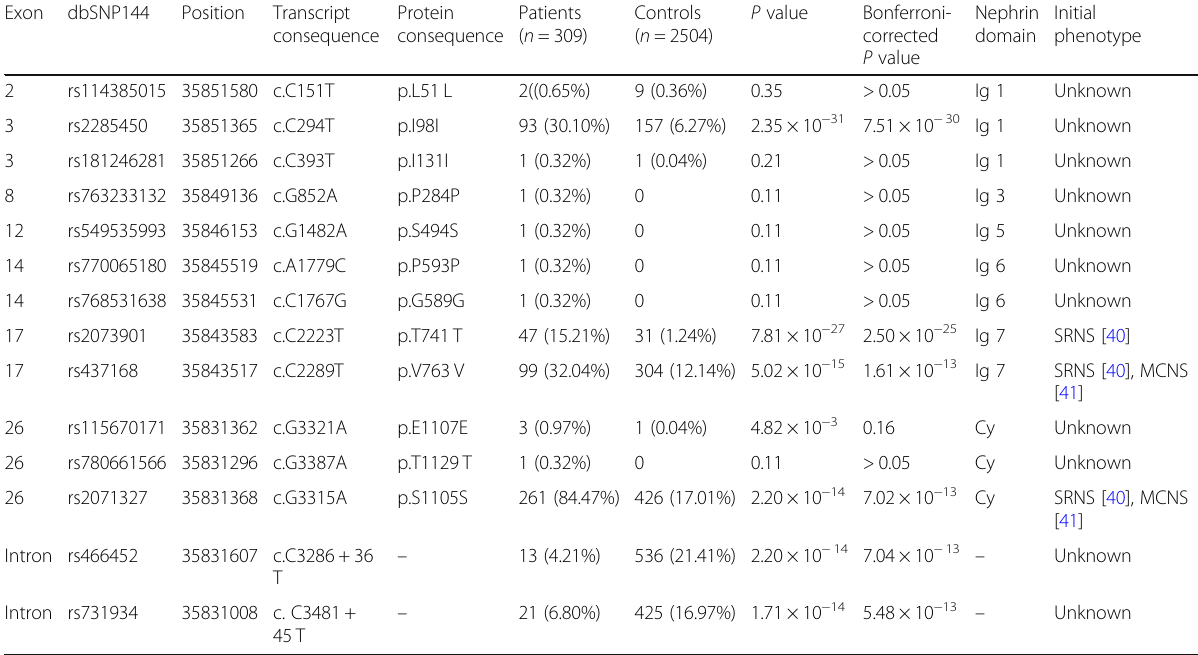
Table 1 The synonymous mutations detected in FSGS patients and compared with controls from 1000 Genomes Project Exon